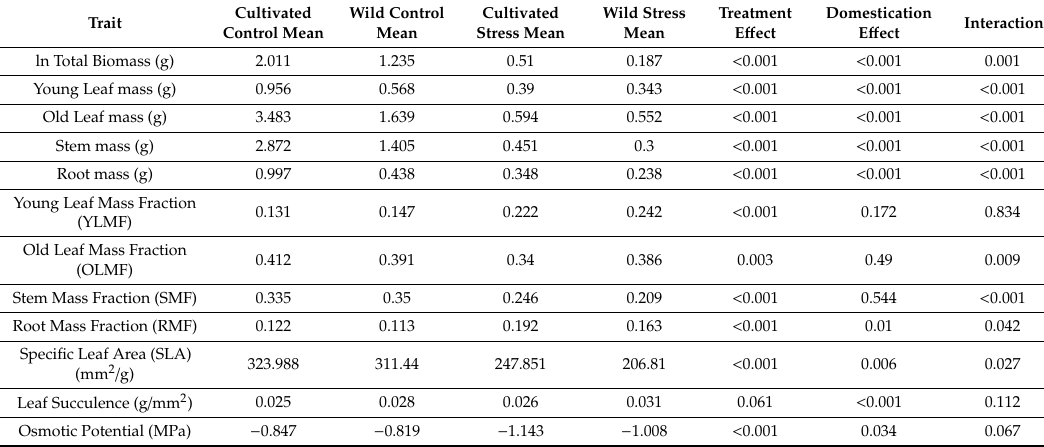
Table 1. Mean values of non-elemental plant traits and p -value significance of Wald’s Chi-square test on treatment, domestication status, and their interaction (treatment × domestication status). Trait Cultivated Control Mean Wild Control Mean Cultivated Stress Mean Wild Stress Mean Treatment E ff ect Domestication E ff